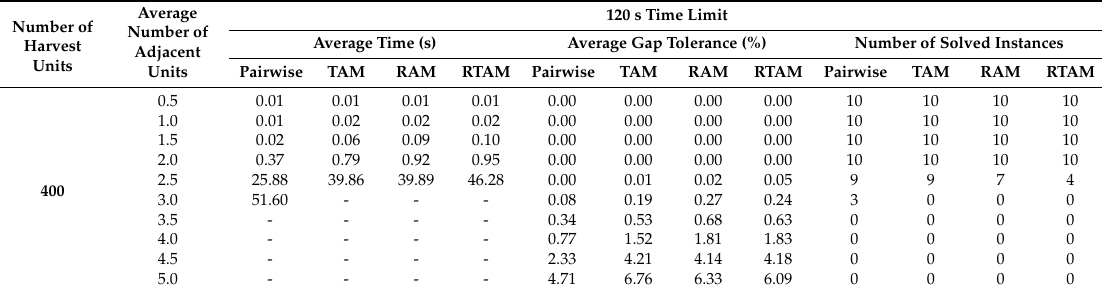
Table 9. Solving time, gap tolerance and number of solved instances for 120 s time limit and 400 harvest units.